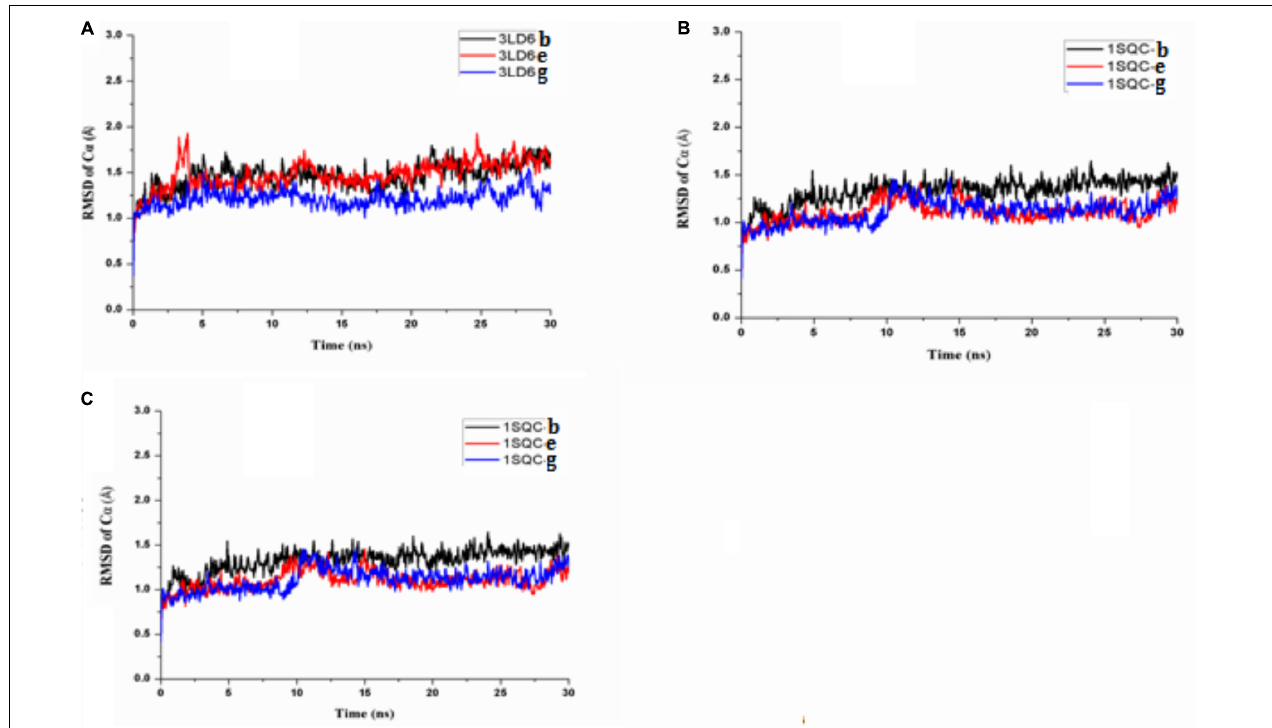
FIGURE 9 | Molecular dynamics simulation of compounds with 3LD6, 1SQC, and 1LQ2: (A) molecular dynamics simulation of compounds with 3LD6; (B) molecular dynamics simulation of compounds with 1SQC; (C) molecular dynamics simulation of compounds with 1LQ2.